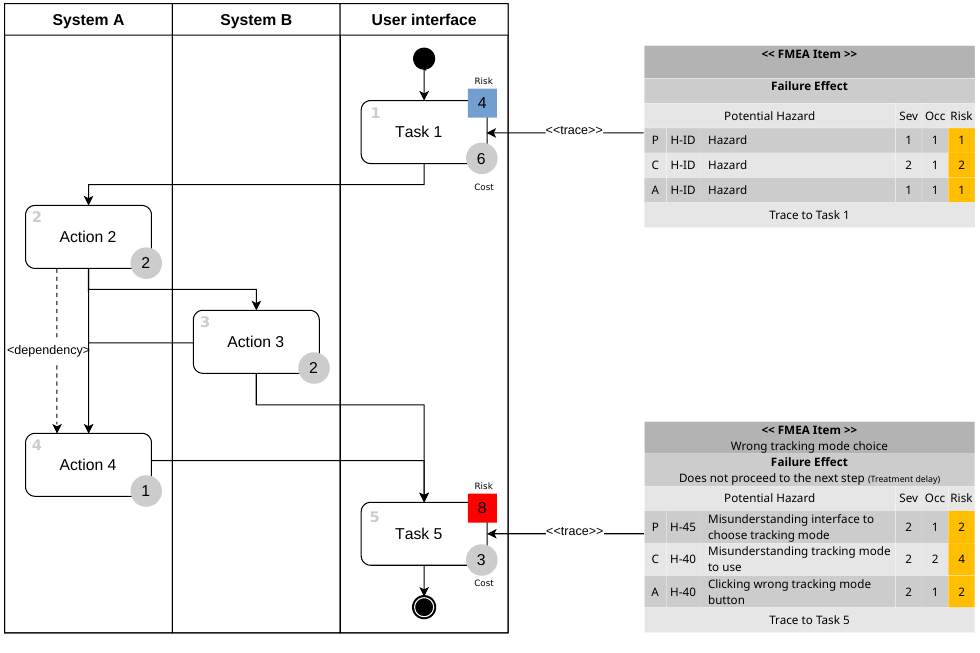
Figure 4. Extended uFMEA-based activity